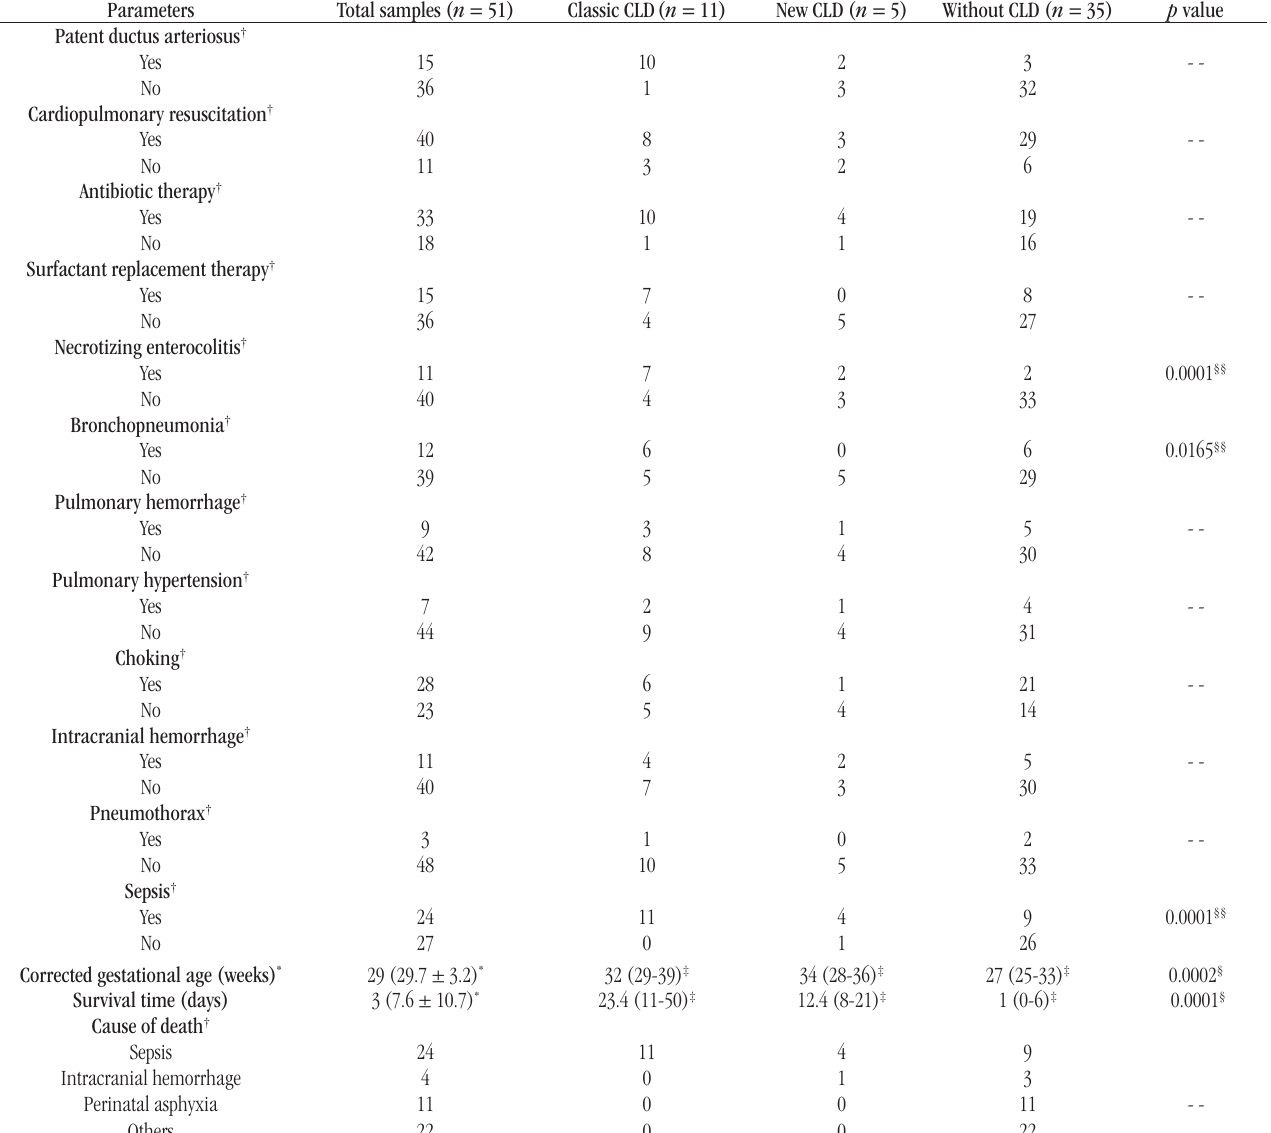
taBLE 3 − The postnatal factors for the three groups